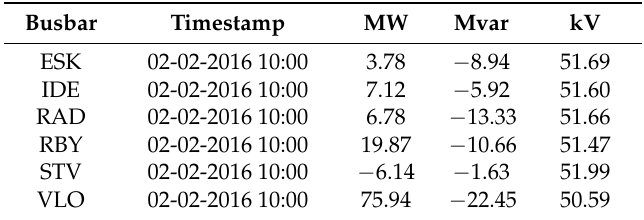
Table 2. Exchange of reactive power away from the transmission system operator (TSO), a low wind and low load